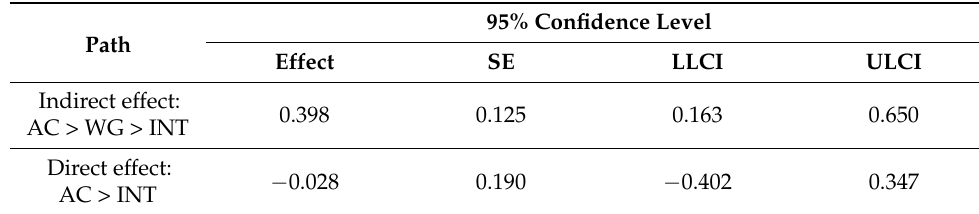
Table 3. Mediation analysis in study